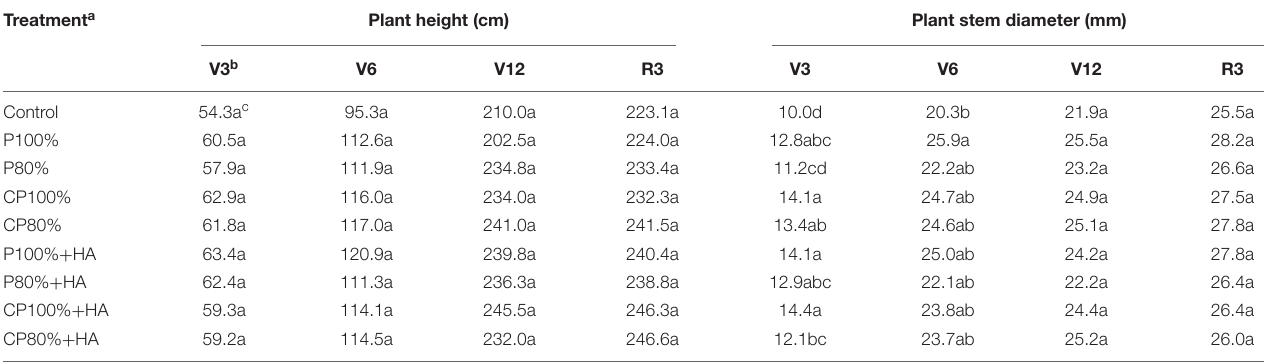
TABLE 1 | Plant height and stem diameter of maize in different fertilization treatments. Treatment a Plant height (cm)